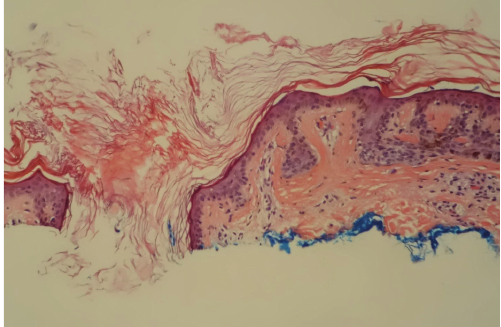
Figure 4: DN appears not to extend to the hair follicle (H&E; 20x).